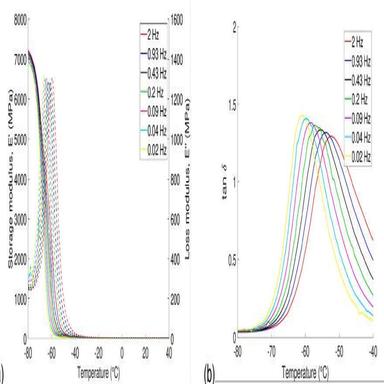
DMA results for F-NR4: (a) temperature dependent storage (solid line) and loss (dashed line) moduli and (b) loss tangents.